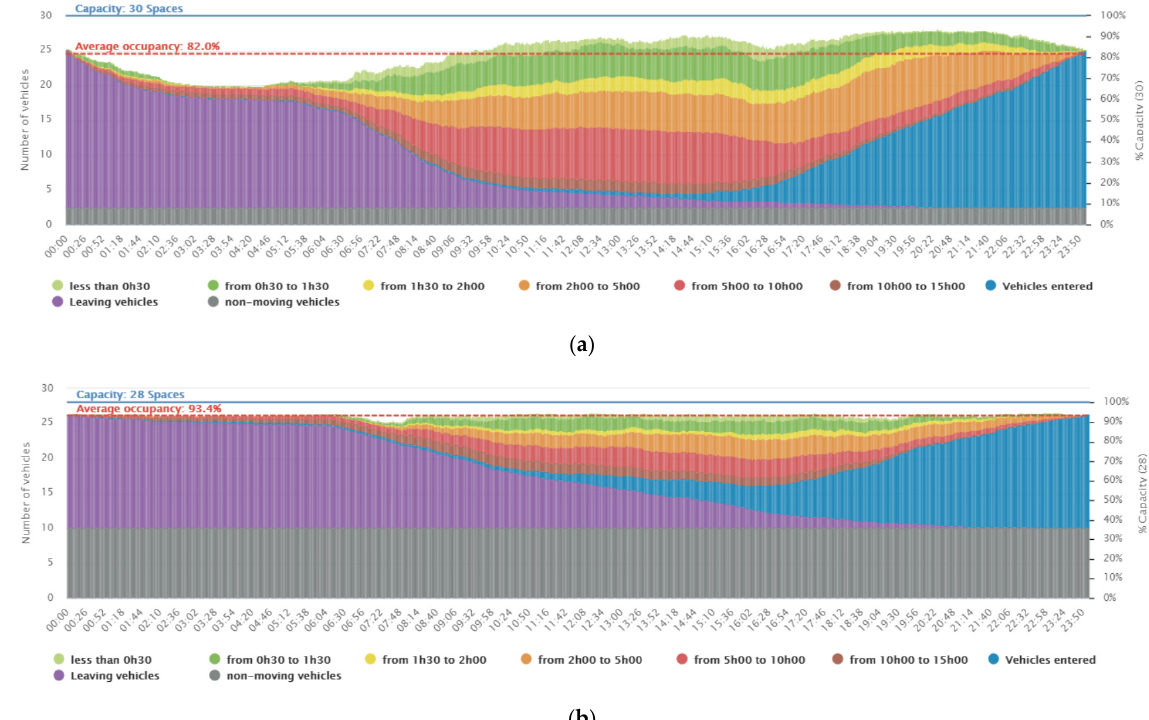
Figure 2. Average occupancy of the selected residential area (Rue des Pâquis, Geneve): ( a ) before the confinement period (between 5 January and 5 February 2020), and ( b ) during the confinement period (between 1 and 30 April 2020).